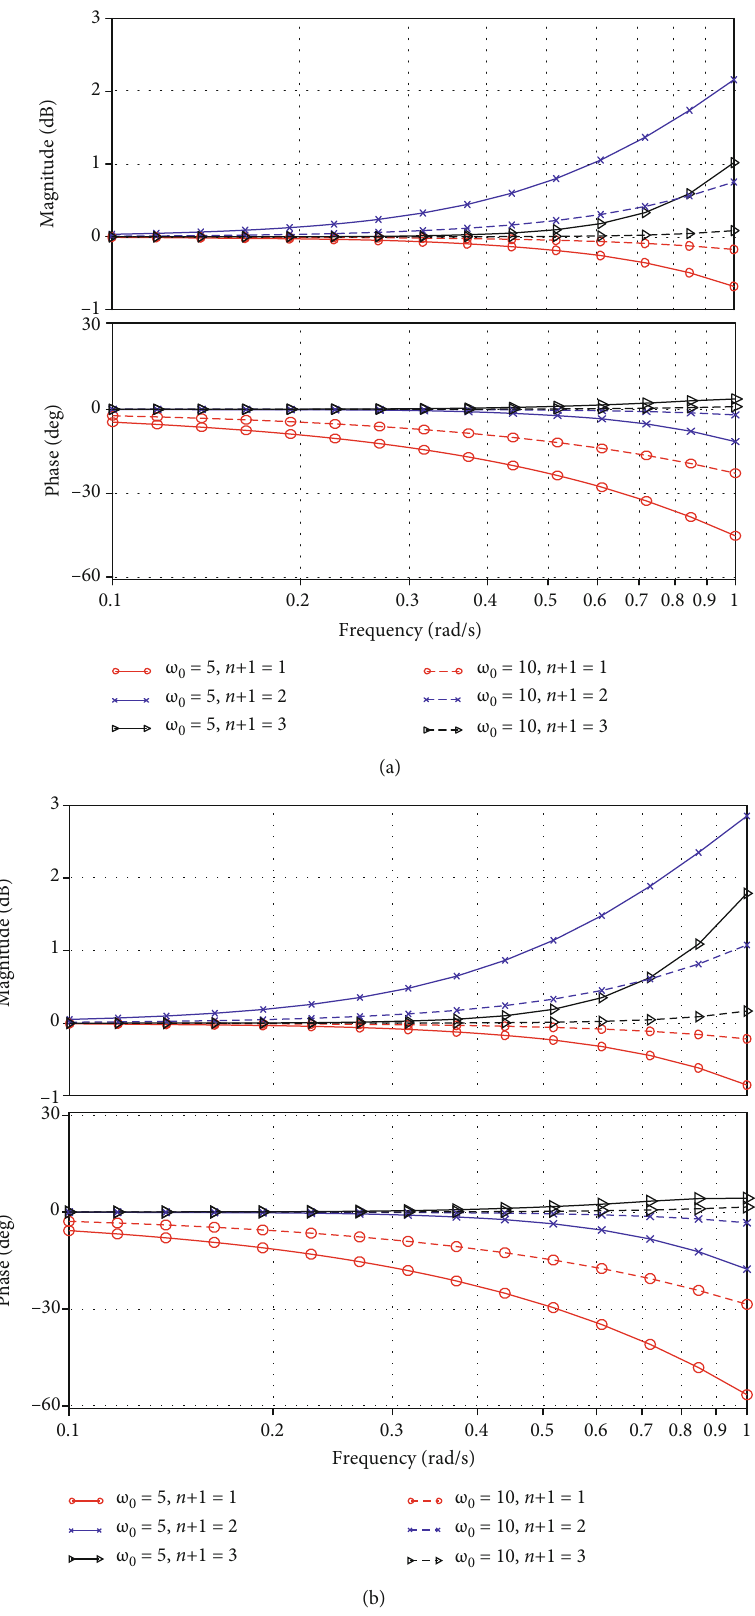
Figure 2: Low-frequency characteristics of high-order LESO disturbance estimates: (a) system order is 3; (b) system order is